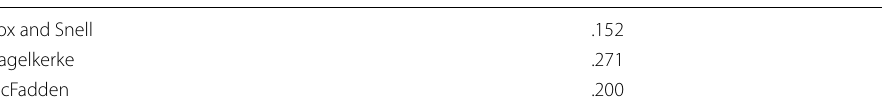
Table 6 Pseudo R 2